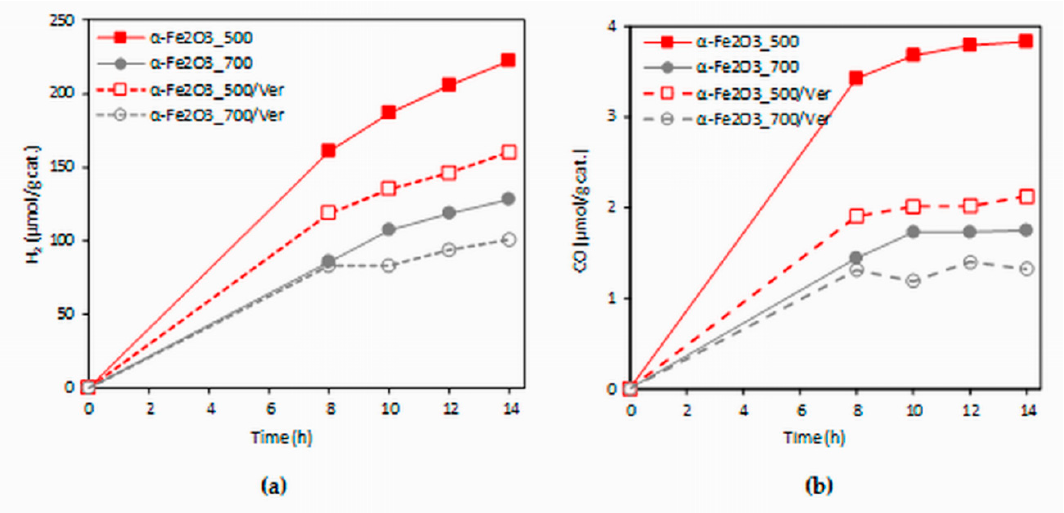
Figure 9. Time dependence of yields of: ( a ) H 2 and ( b ) CO during the CO 2 photocatalytic reduction in the presence of investigated photocatalysts.